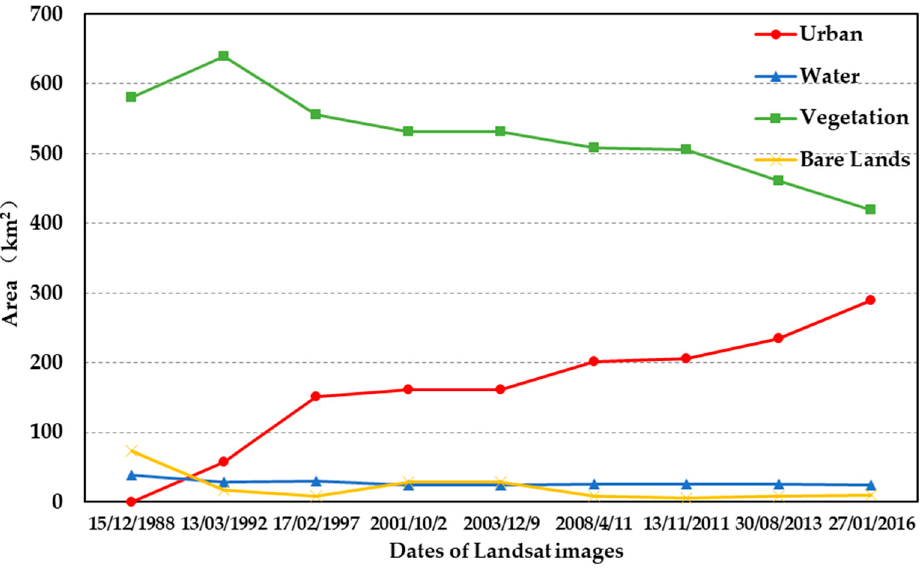
Figure 5. Urban land cover change in Colombo from 1988 to 2016.